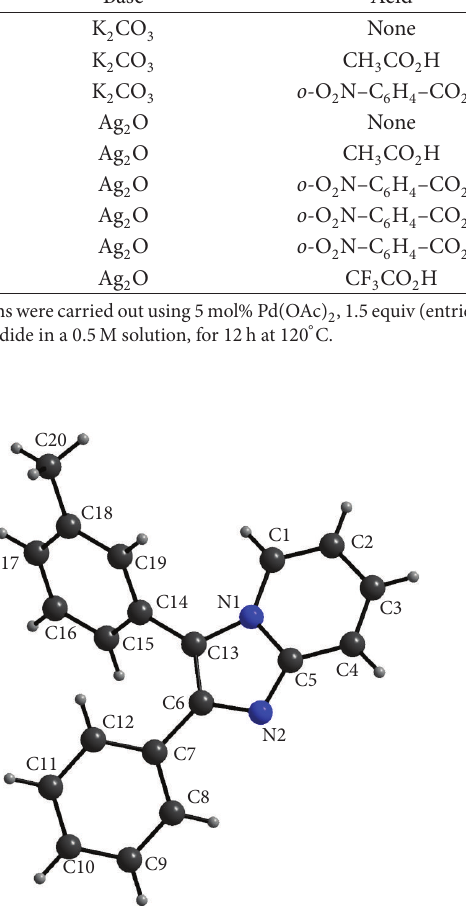
F 2: Molecular structure of the compound 3c (entry 3). (X- ray data was collected on a Bruker AXS-SMART diffractometer using